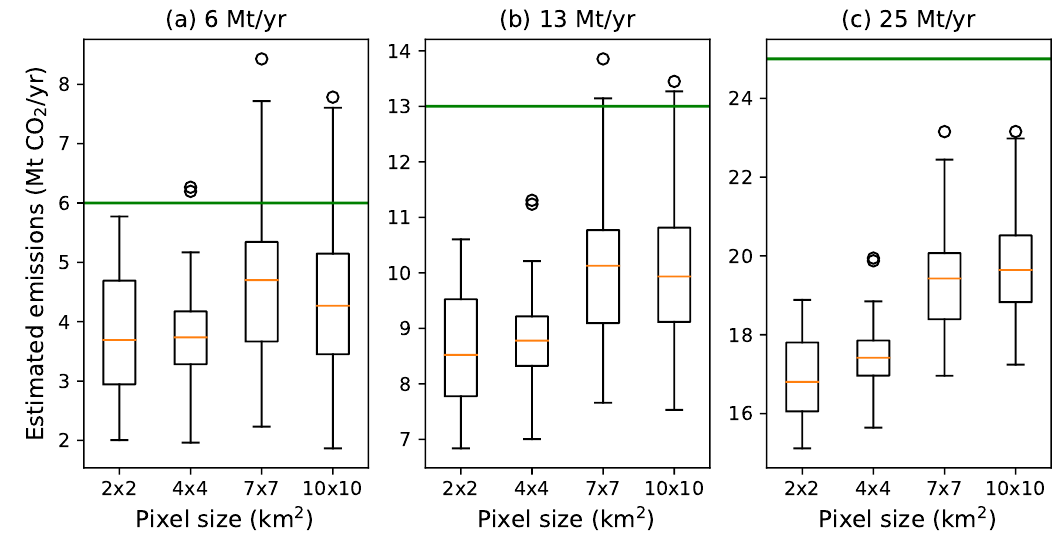
Figure 8. Emission rate estimates for all 12 combinations of pixel sizes and emission rates for an ensemble of 30 simulations as in Figure 5, with a simulated wind at 45 ◦ and a modelled direction of 35 ◦